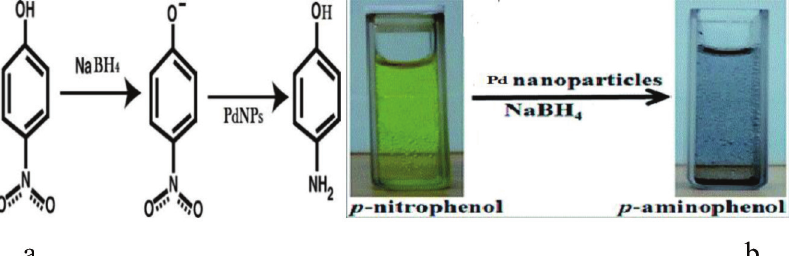
Figure 10: (a) Mechanism of the reaction. (b) Color changes in the